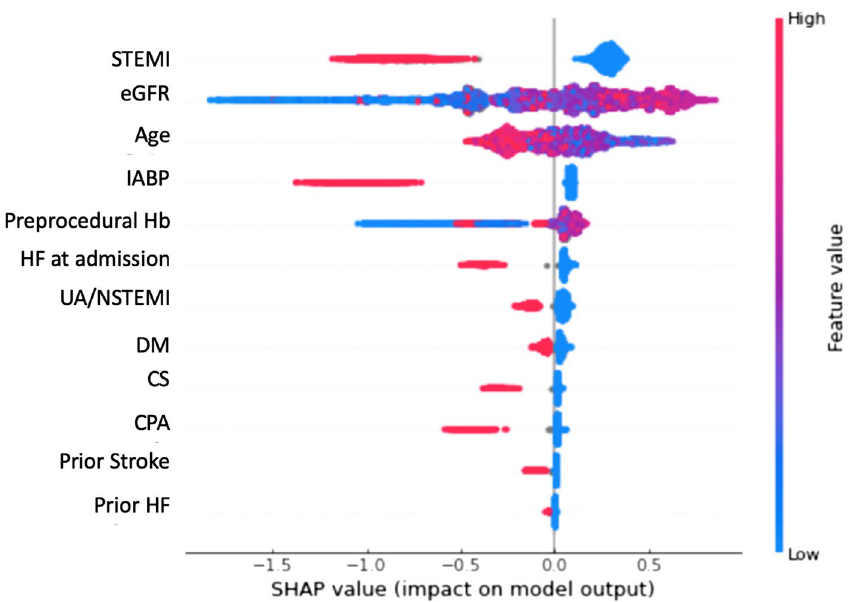
Figure 2. SHAP model to estimate important variables with the light gradient boosting model using the 12 NCDR variables. The features are sorted in descending order by Shapley values. Abbreviations: CS: cardiogenic shock; CPA: cardiopulmonary arrest; DM: diabetes mellitus, Hb: hemoglobin; HF: heart failure, IABP: intra- aortic balloon pump; STEMI: ST-elevation myocardial infarction; UA/NSTEMI: unstable angina/non-ST elevation myocardial